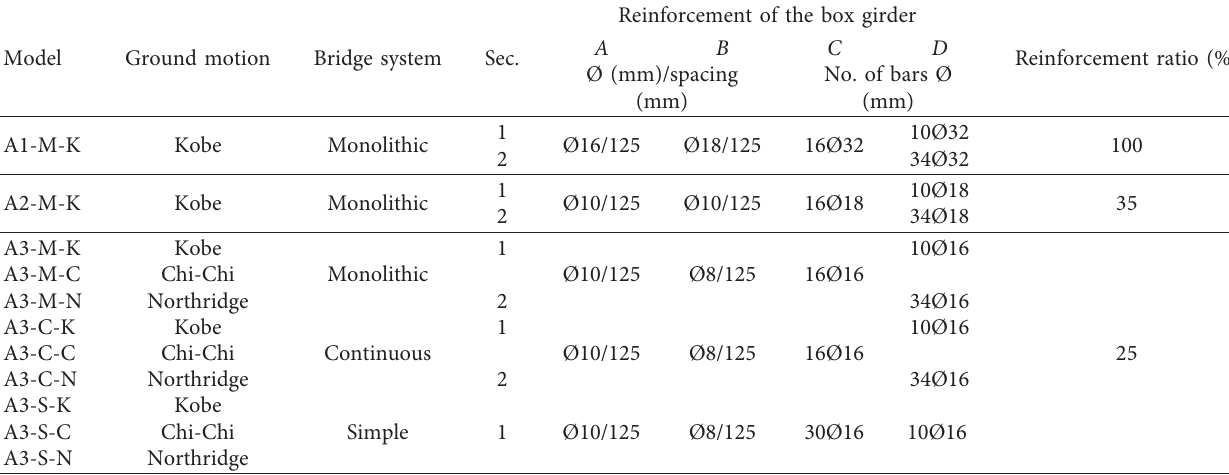
Figure 12: Dimensions of the box girder and reinforcement details of the bridge elements. Table 2: Bridge models and box girder reinforcements (unit: